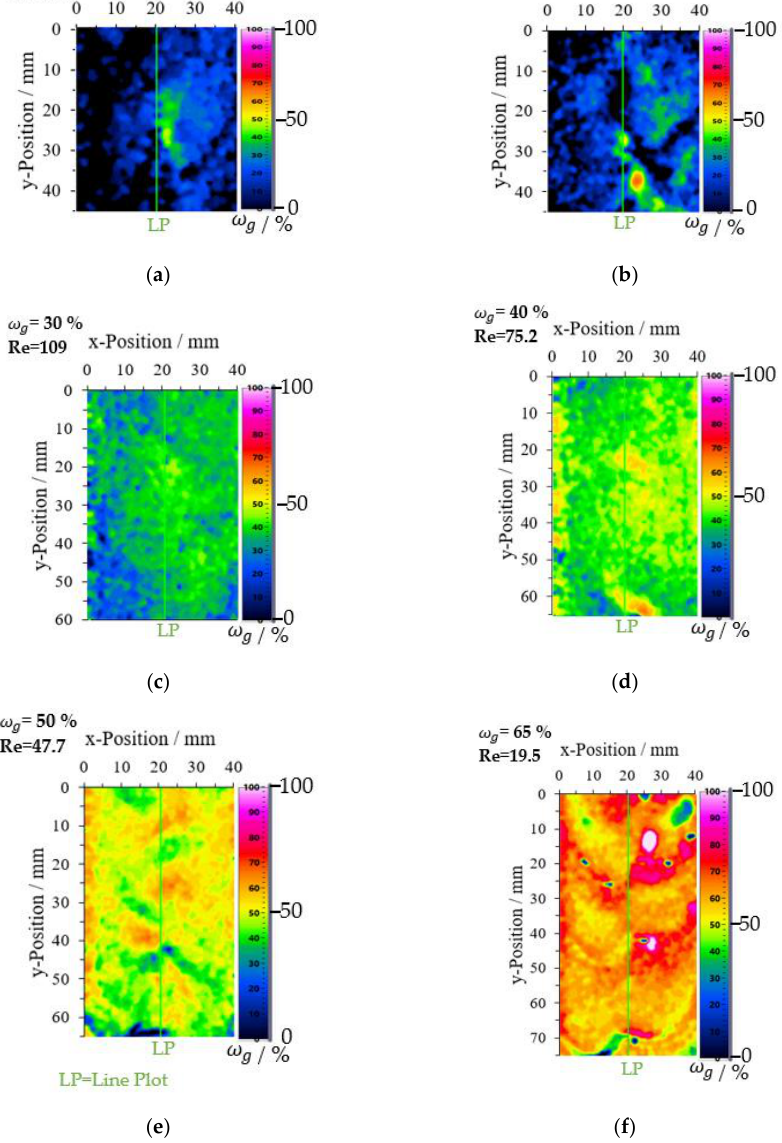
Figure 14. Glycerol mass concentration fields for the falling film from ω g = 0 to 0.65 g glyc g total − 1 cal- culated with a film thickness image and the 1450 nm absorbance image. ( a ) ω g = 0 g glyc g total − 1 and Re = 256 ( b ) ω g = 0.20 g glyc g total − 1 and Re = 152 ( c ) ω g = 0.30 g glyc g total − 1 and Re = 109 ( d ) ω g = 0.40 g glyc g total − 1 and Re = 75.2 ( e ) ω g = 0.50 g glyc g total − 1 and Re = 47.7 ( f ) ω g = 0.65 g glyc g total − 1 and Re =